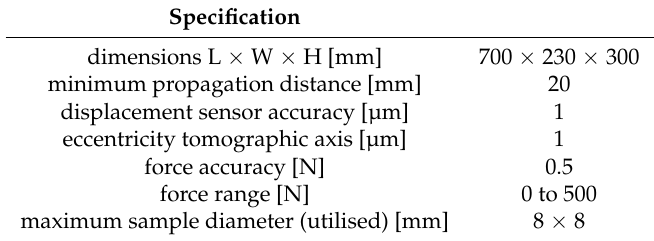
Table 1. Specifications of the TomoPress relevant for operation at beamline ID19 of the